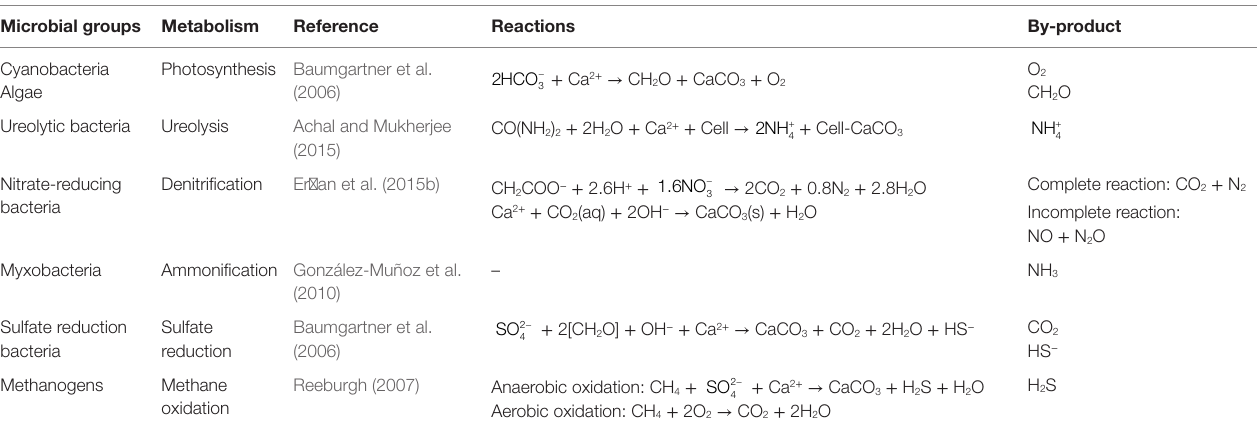
TABLe 1 | Reactions and by-products involved in different metabolic pathways leading to